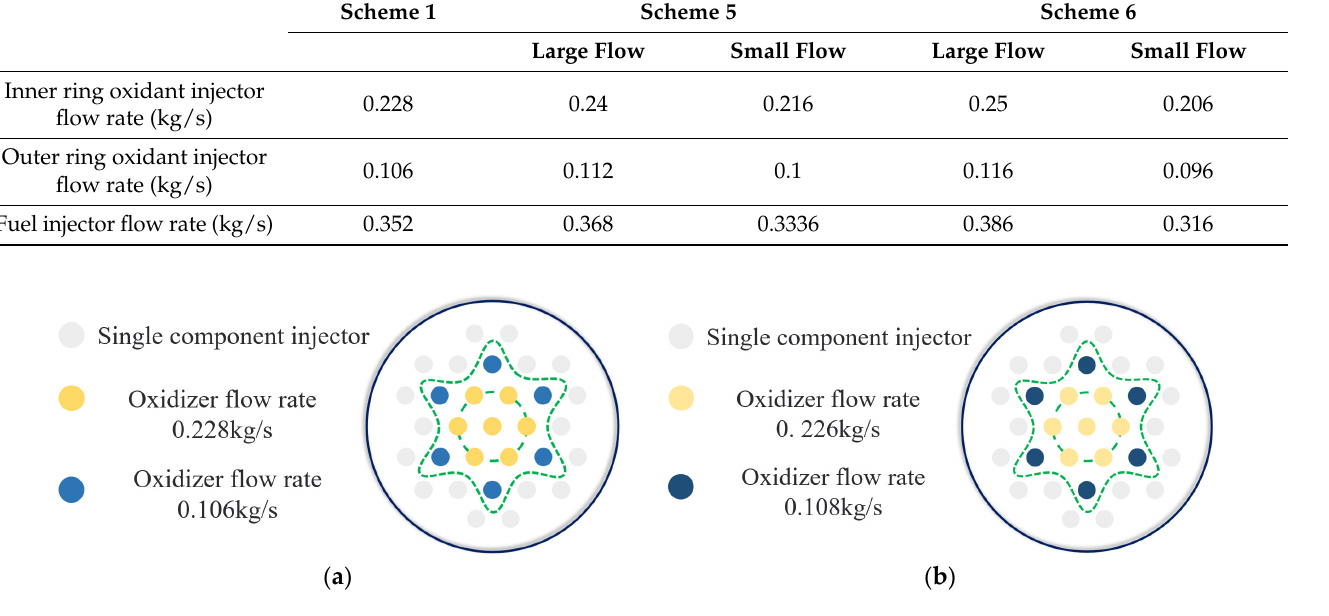
Figure 5. Example of flow change. ( a ) Scheme 1. ( b ) Scheme 7. Table 4. Setting for Schemes 7 and 8.